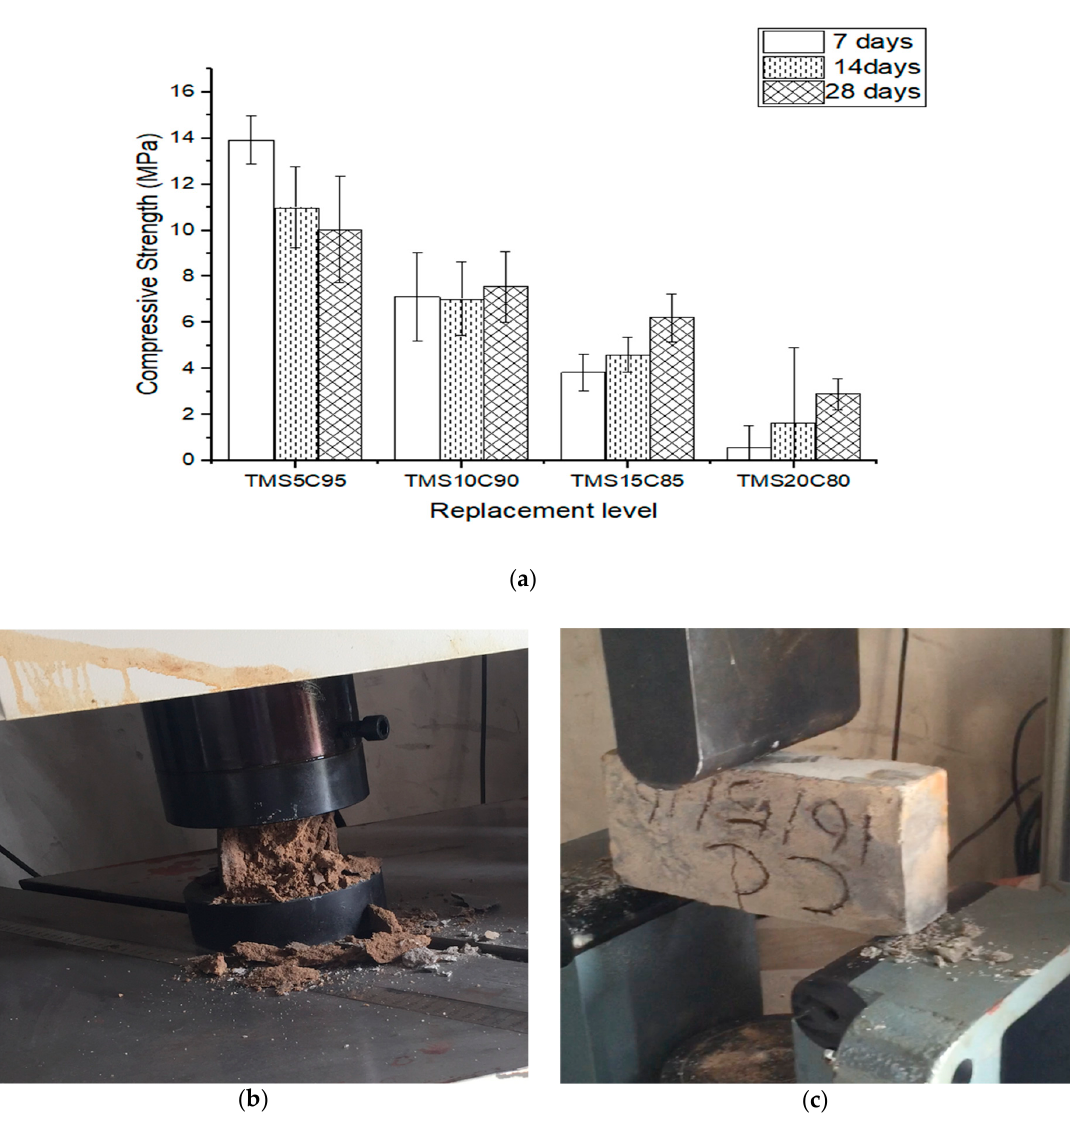
Figure 6. ( a ) Compressive strength of the samples at 5%, 10%, 15% and 20% stabilizations designated as TMS5C95, TMS10C90, TMS15C85 and TMS20C80 respectively at the different curing ages (7, 14 and 28 days), ( b ) specimen failing under compression, ( c ) specimen’s failure under three-point bending